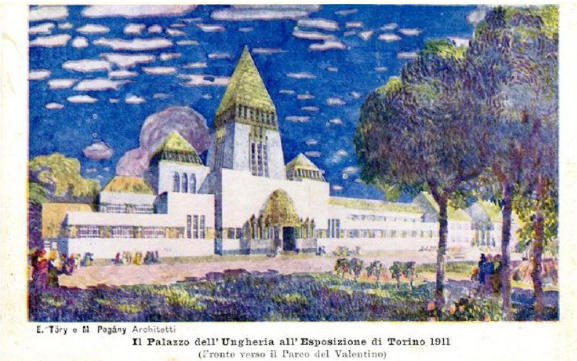
Figure 5. 1911 colour postcard of the Pavilion of Hungary (CDC private collection)